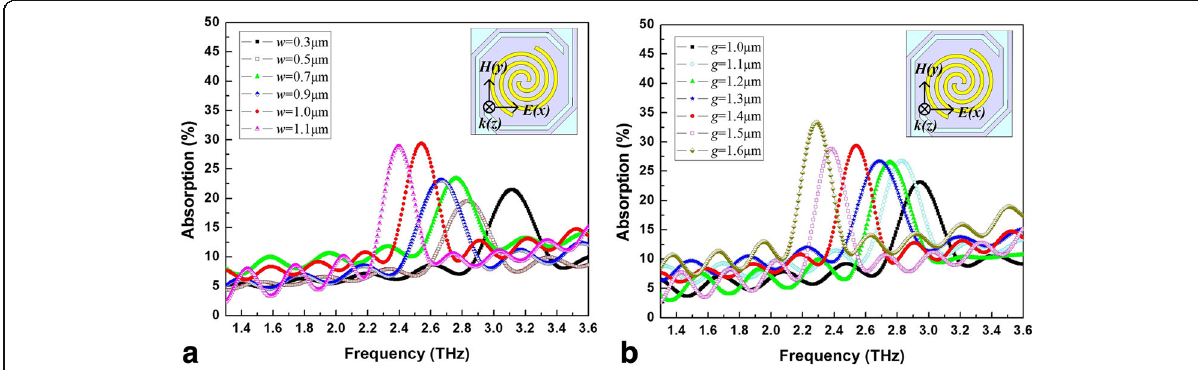
Fig. 3 THz wave absorption curves of micro-bridge structures with spiral-type antenna on the support layer when n = 1.6 with different line width ( a ) and different spacing ( b